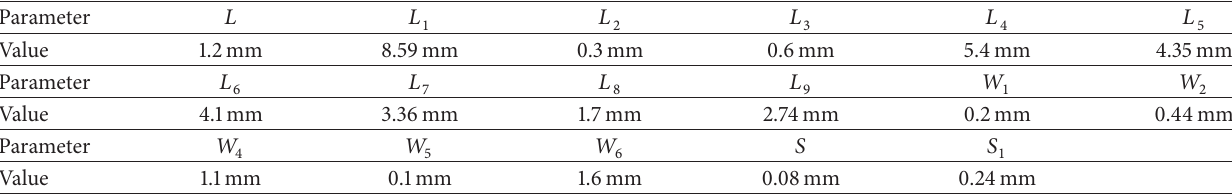
Table 1: Optimized values of the given broadband band-pass